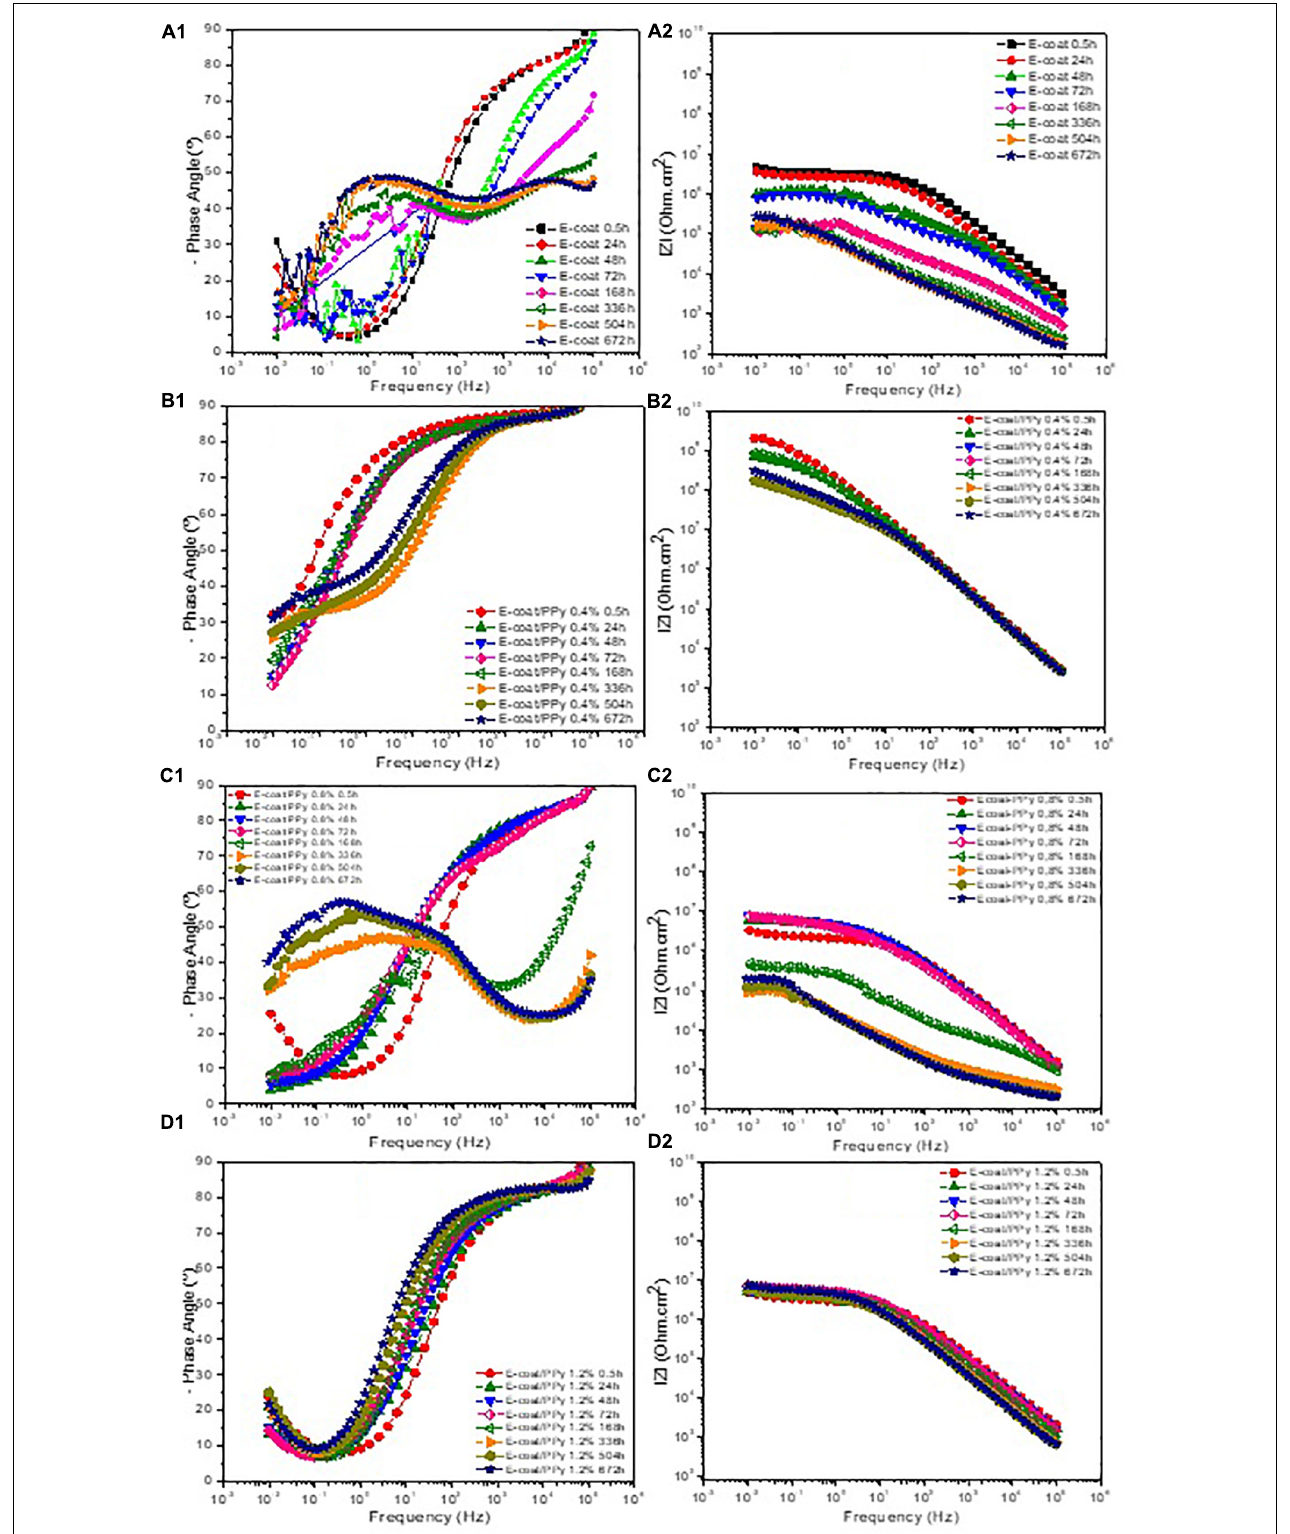
FIGURE 6 | Bode diagram for neat e-coat (A1,A2) , e-coat/PPy 0.4% by weight (B1,B2) , e-coat/PPy 0.8% by weight (C1,C2) , and e-coat/PPy 1.2% by weight (D1,D2) during 672 h exposure.